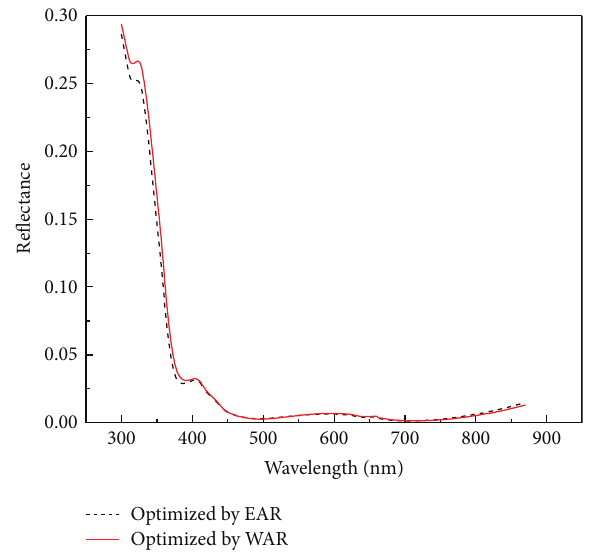
Figure 4: Optimal SiO 2 /ZnS ARC reflectivity versus wavelength. the optimal parameters of the SiO 2 /ZnS ARC for the Ga 0.5 In 0.5 P/GaAs/Ge triple-junction SC under AM1.5 con- ditions. The reflectivity curves of SiO 2 /ZnS films optimized by 𝑅 𝑒 and 𝑅 𝑤 are shown in Figure 7. The SiO 2 /ZnS ARC parameters for the triple-junction SC optimized by different methods are summarized in Table 2.